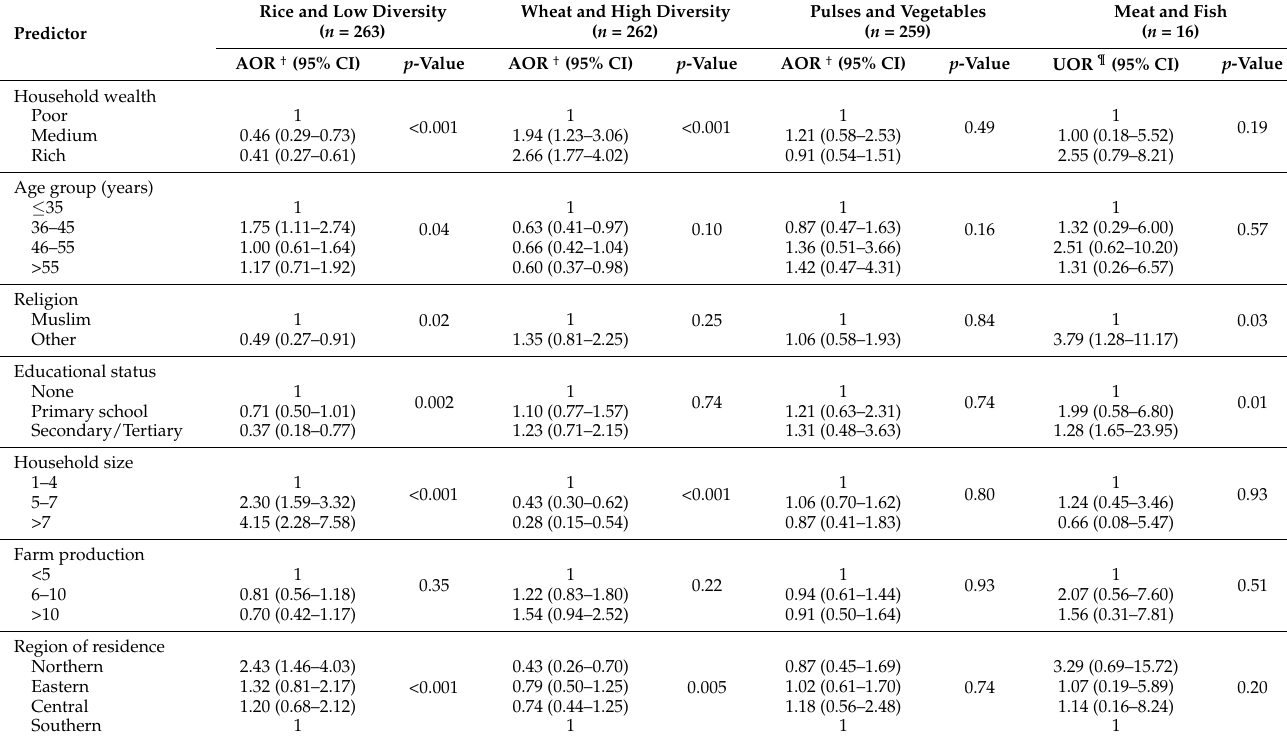
Table 3. Predictors of dietary pattern in Bangladesh (mixed effects logistic regression). Rice and Low Diversity ( n = 263)